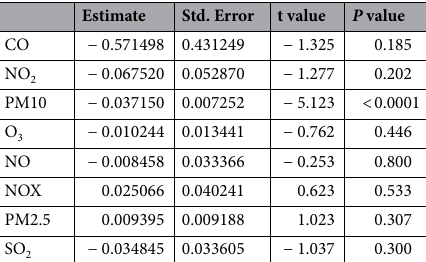
Estimate Std. Error t